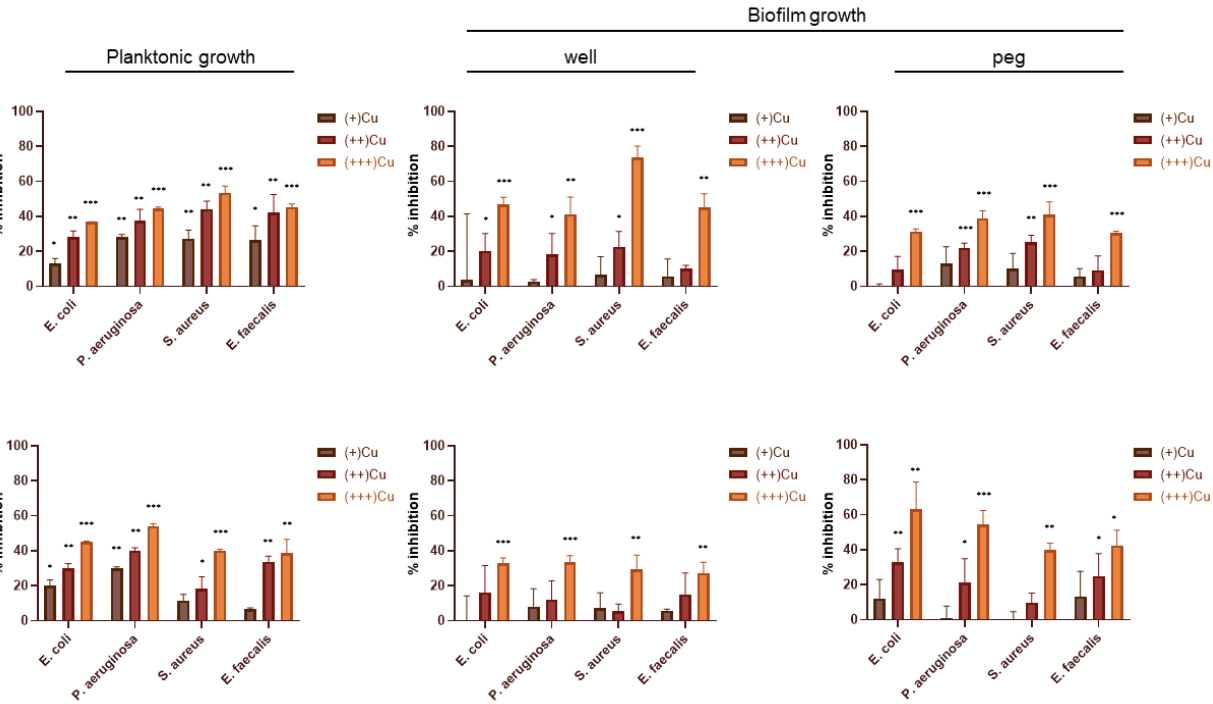
Figure 4. Antibacterial and antibiofilm activities exerted by Cu coatings against the four bacterial pathogens E. coli , P. aeruginosa , S. aureus , and E. faecalis . The results are reported as the mean of the percentage of bacterial and biofilm inhibition ± standard deviation. Statistical analysis was performed compared to control experiments (100% of growth) using one-way ANOVA test. Differences were considered significant for p < 0.05 (* p < 0.05, ** p < 0.01, *** p <